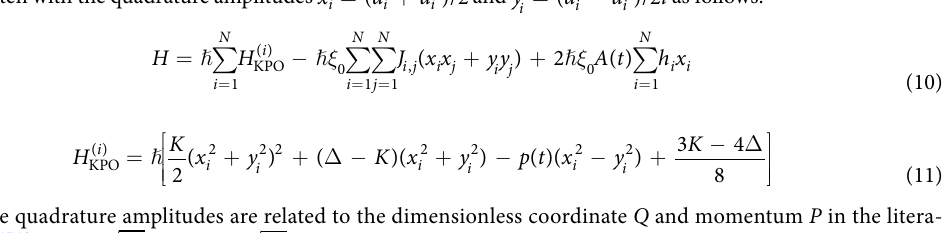
obtain 1 . This comparison shows that the probability distributions of the spin configu-